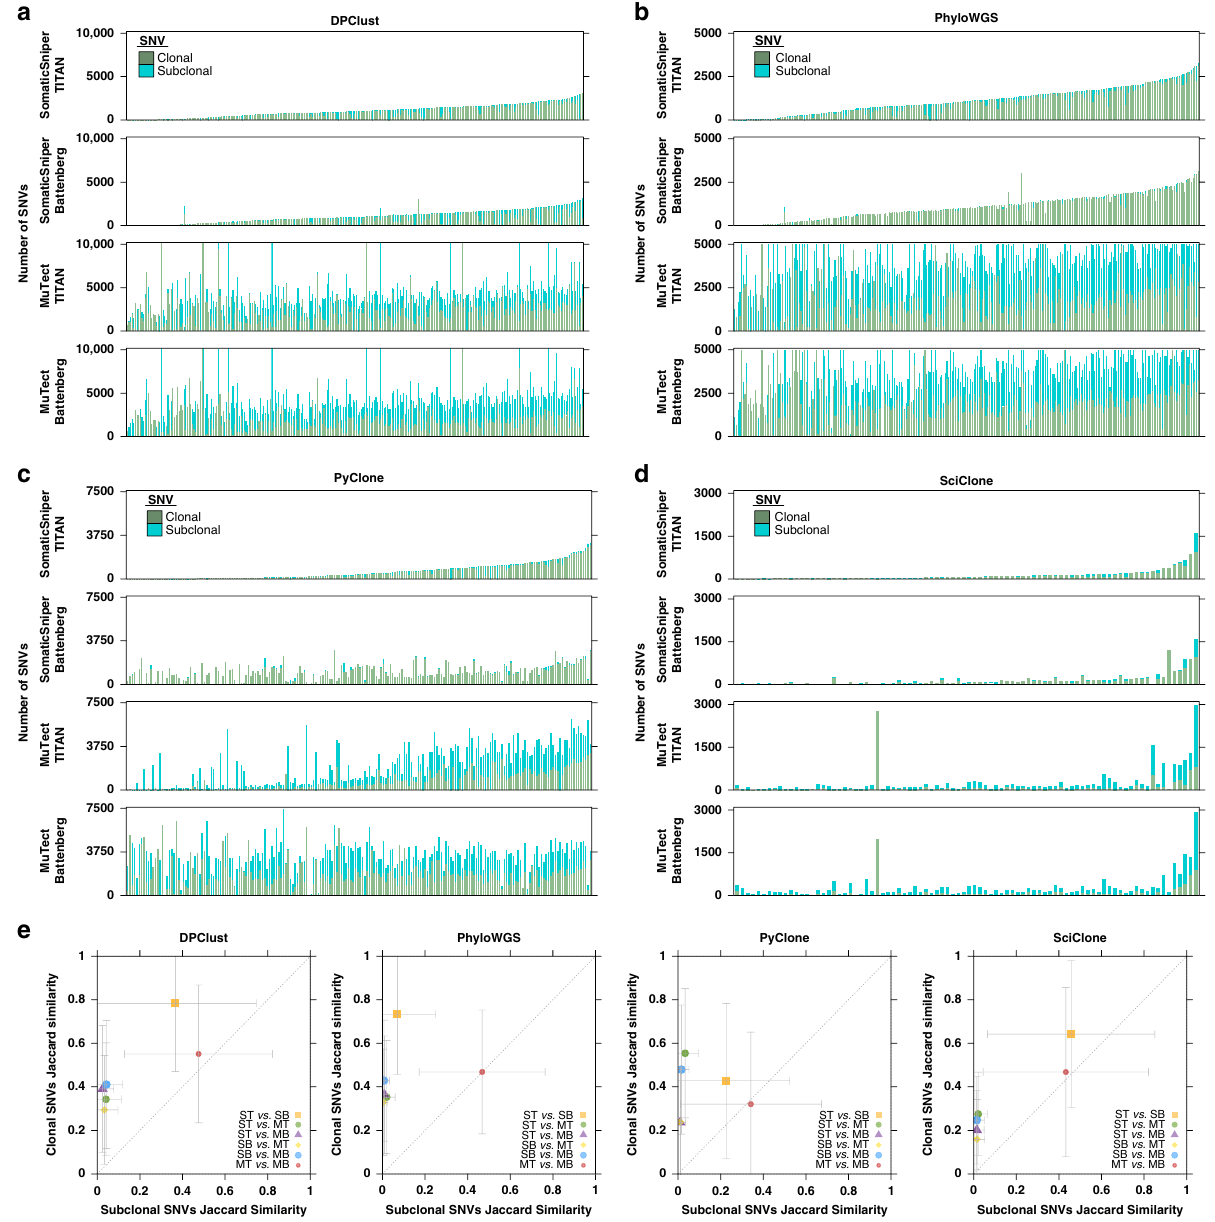
Fig. 5 Change in SNV detection impacts subclonal SNV pro fi les more than clonal SNV pro fi les. Total number of clonal and subclonal SNVs identi fi ed by pipelines using a DPClust, b PhyloWGS, c PyClone and d SciClone. Each stacked bar represents one sample and samples are ordered based on the total number of SNVs identi fi ed by the pipeline using SomaticSniper and TITAN. Color of the stacked bar re fl ects the clonality of the SNVs it represents (clonal green, subclonal blue). Only samples with successful executions across all four pipelines using the subclonal reconstruction algorithm are presented. DPClust: n = 281 biologically independent samples; PhyloWGS n = 274; PyClone n = 200; SciClone n = 86. e Jaccard index of pipeline-identi fi ed clonal and subclonal SNVs. Each marker (delineated by shape and color) represents a pipeline pair that is compared, and the x - and y -axis show subclonal and clonal mean SNV Jaccard indices across samples shared between the pipeline pair, respectively, with error bars indicating one standard deviation. Dashed diagonal line represents the y = x line. ST, SomaticSniper-TITAN; MT, MuTect-TITAN; SB, SomaticSniper-Battenberg; MB, MuTect-Battenberg; SNV, single nucleotide variant. DPClust ST vs. SB: n = 291 independent observations; DPClust ST vs. MT: n = 283; DPClust ST vs. MB: n = 288; DPClust SB vs. MT: n = 281; DPClust SB vs. MB: n = 288; DPClust MT vs. MB: n = 281; PhyloWGS ST vs. SB: n = 288; PhyloWGS ST vs. MT: n = 290; PhyloWGS ST